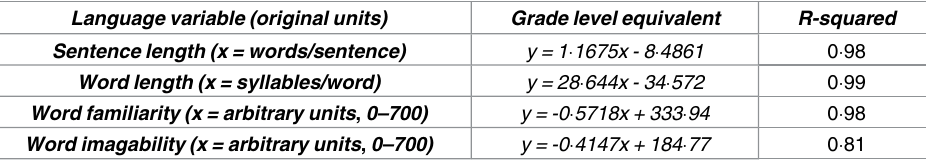
Table 2. Regression equations to calculate language variable grade